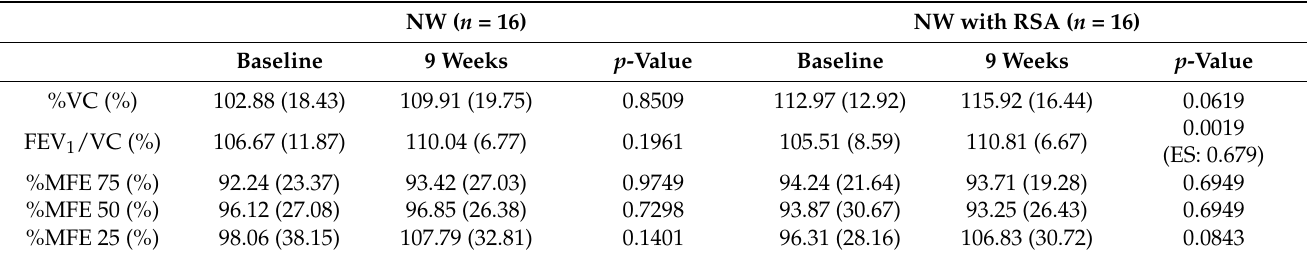
Table 4. Spirometry parameters of women subjected to an eight-week NW and NW with RSA training